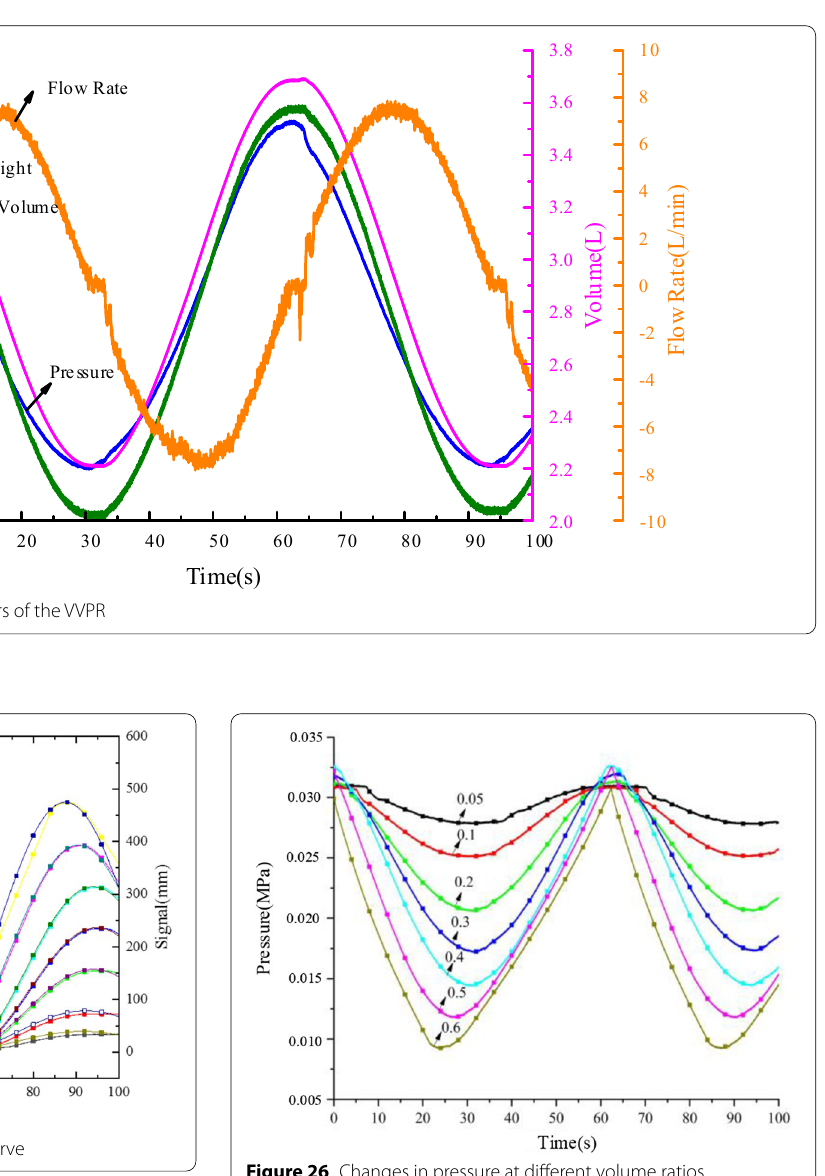
Figure 26 Changes in pressure at different volume